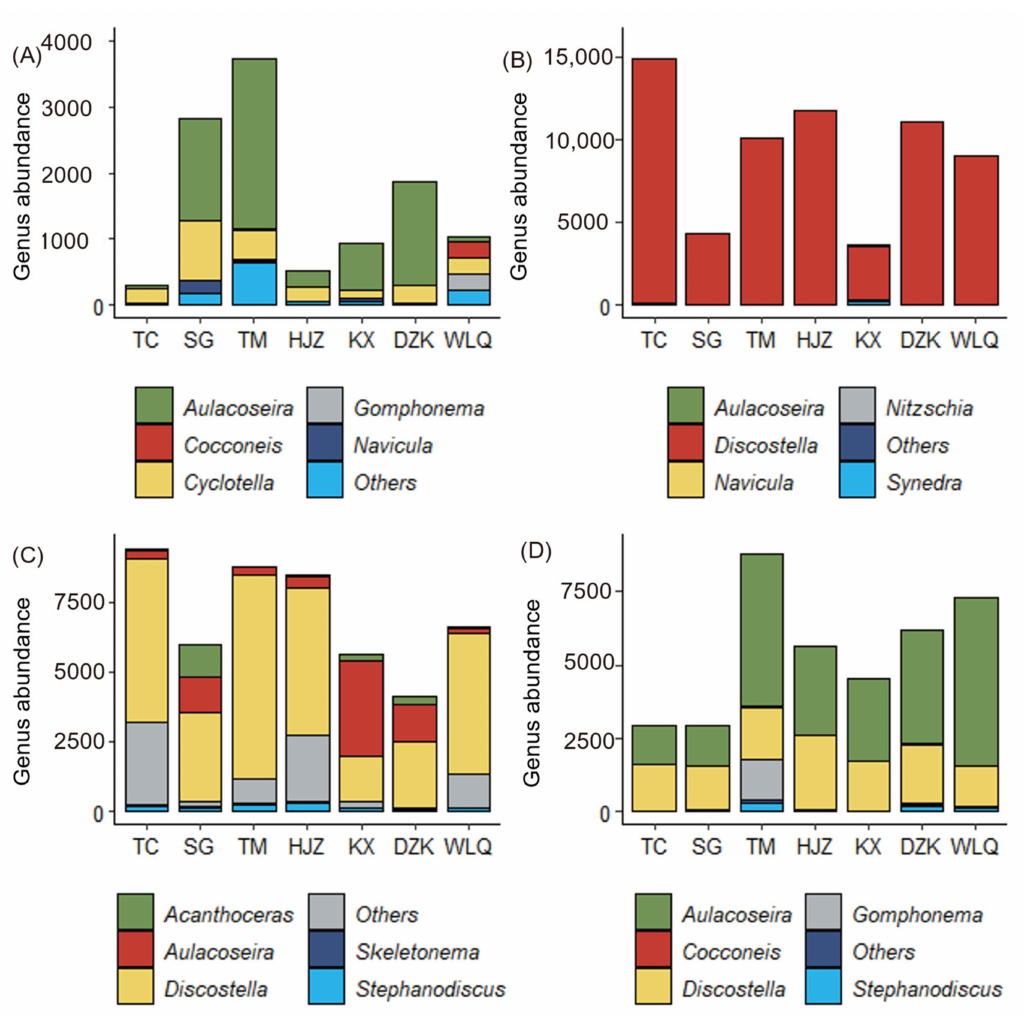
Figure 4. Spatial distribution of diatoms at the genus level in Danjiangkou Reservoir (( A ) is spring, ( B ) is summer, ( C ) is autumn, and ( D ) is